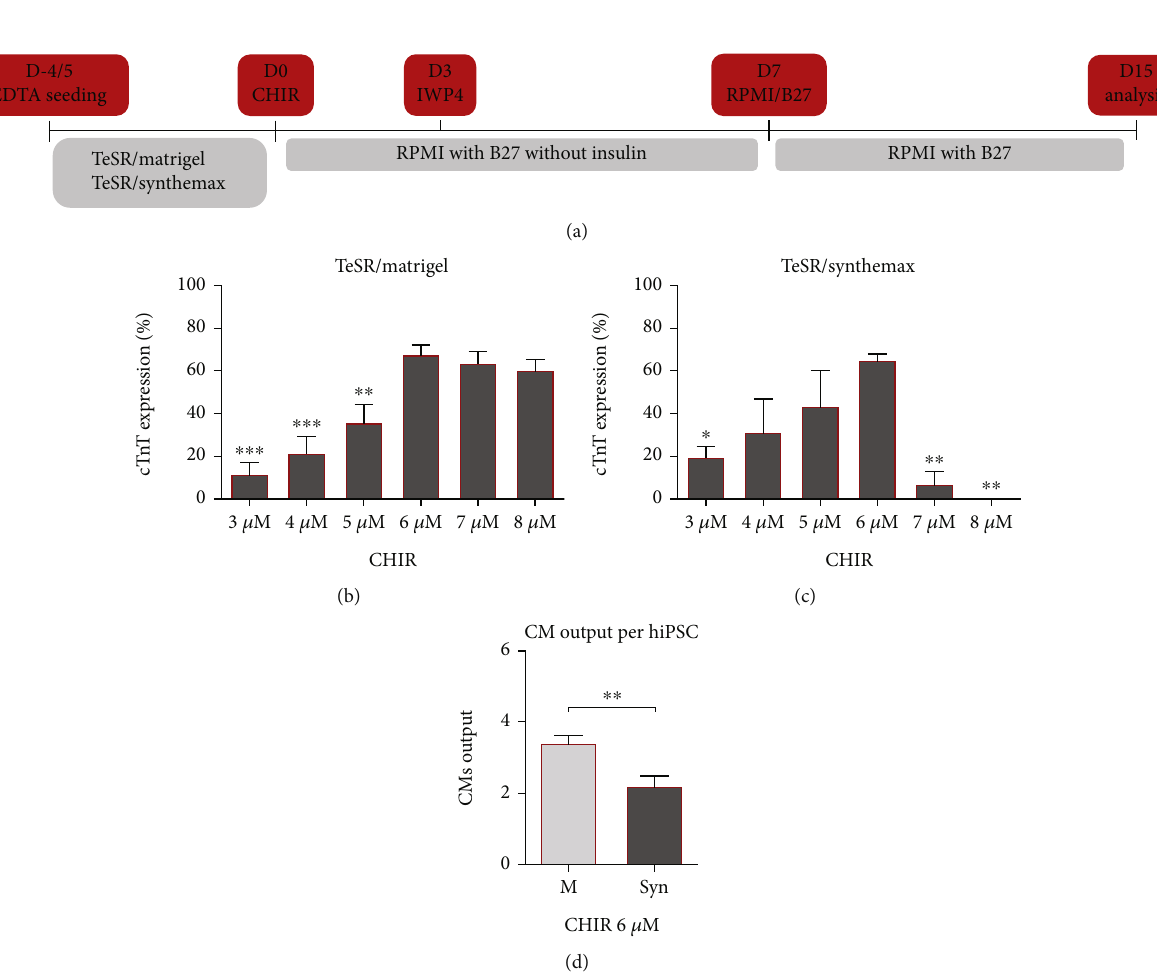
Figure 1: Optimization of hiPSC cardiac di ff erentiation by WNT signaling modulation using di ff erent culture systems. (a) Cardiomyocyte di ff erentiation protocol adapted from Lian et al. [29] using enzyme-free passaging and seeding. WNT signaling activation using CHIR was performed for 24h, while inhibition using IWP4 was performed for 48 h. (b) E ff ect of CHIR concentration on cardiomyocyte di ff erentiation e ffi ciency in the culture system TeSR/Matrigel by measuring the cardiomyocyte marker cTnT by fl ow cytometry at day 15. Error bars, SEM: n = 5 for 3, 4, and 7 μ M, n = 6 for 5 and 8 μ M, n = 12 for 6 μ M. ∗∗ p value < 0.01, ∗∗∗ p value < 0.001 relative to 6 μ M (ANOVA with Tukey ’ s test). (c) Screening of CHIR concentration impact on cardiomyocyte di ff erentiation e ffi ciency in the culture system TeSR/Synthemax measured by fl ow cytometry at day 15. Error bars, SEM: n = 3 for 3, 4, and 5 μ M, n = 2 for 7 and 8 μ M, n = 7 for 6 μ M. ∗ p value < 0.05, ∗∗ p value < 0.01 relative to 6 μ M (ANOVA with Tukey ’ s test). (d) Cardiomyocyte (CM) output at day 15 per seeded hiPSC for each system using 6 μ M of CHIR. Error bars, SEM: n = 8 for TeSR/Matrigel (M), n = 7 for TeSR/Synthemax (Syn). ∗∗ p value < 0.01 (Welch ’ s t